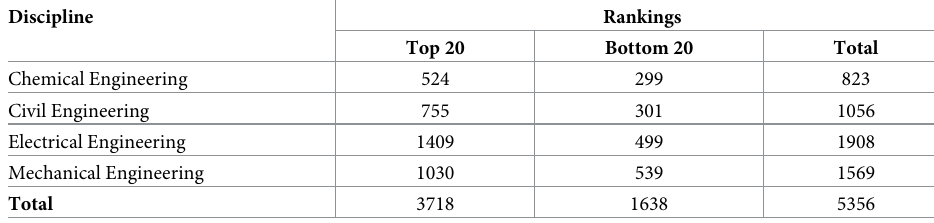
Table 2. Distribution of tenure track faculty of top 20 and bottom 20 institutions throughout engineering discipline. Discipline Rankings Top 20 Bottom